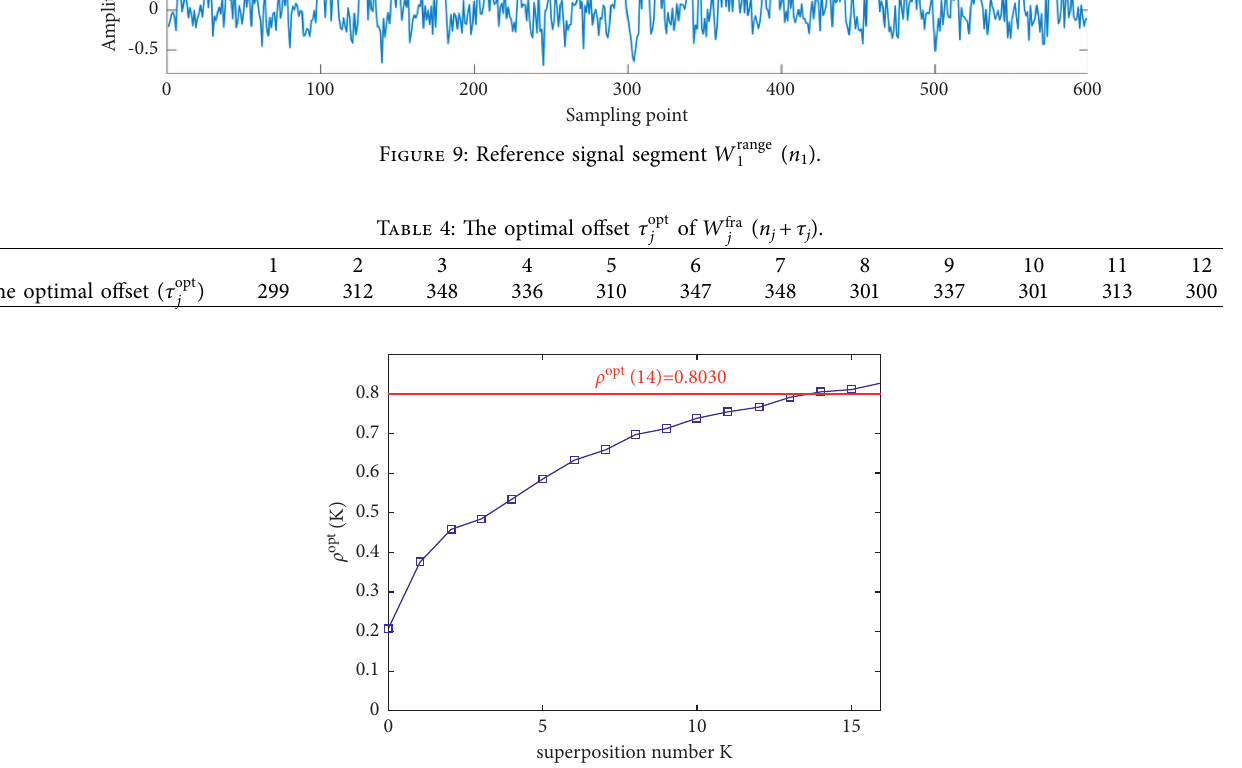
Figure 10: The variation curve of ρ opt ( K ) with the increase of the superimposition number (K).